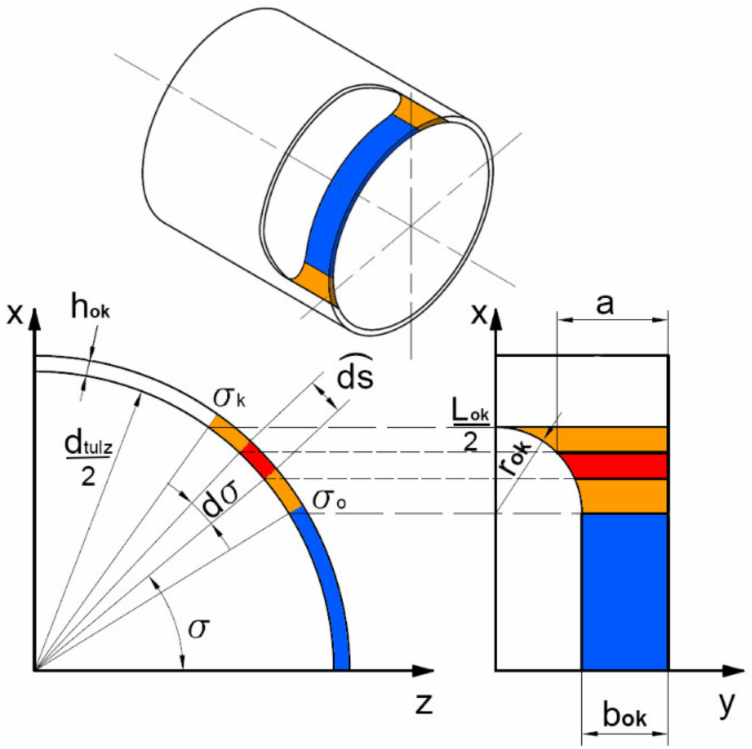
Figure 19. Graphical representation of the model of the commutation window